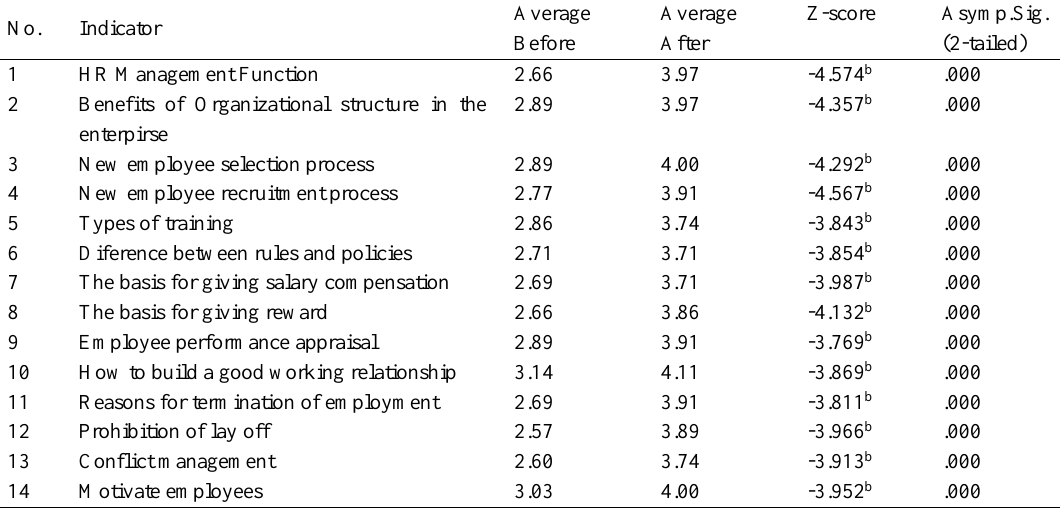
Table 1: Enhancing Employers' Capabilities through